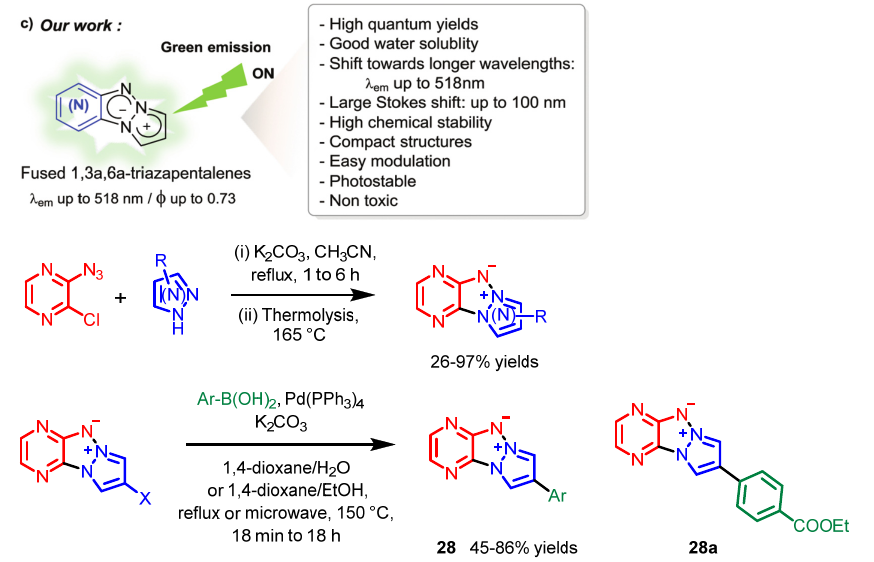
Scheme 23. Top : Summary of triazapentalenes. Bottom : Synthesis of various substituted triazapentalenes 28 and representative 28a . Adapted from [65].